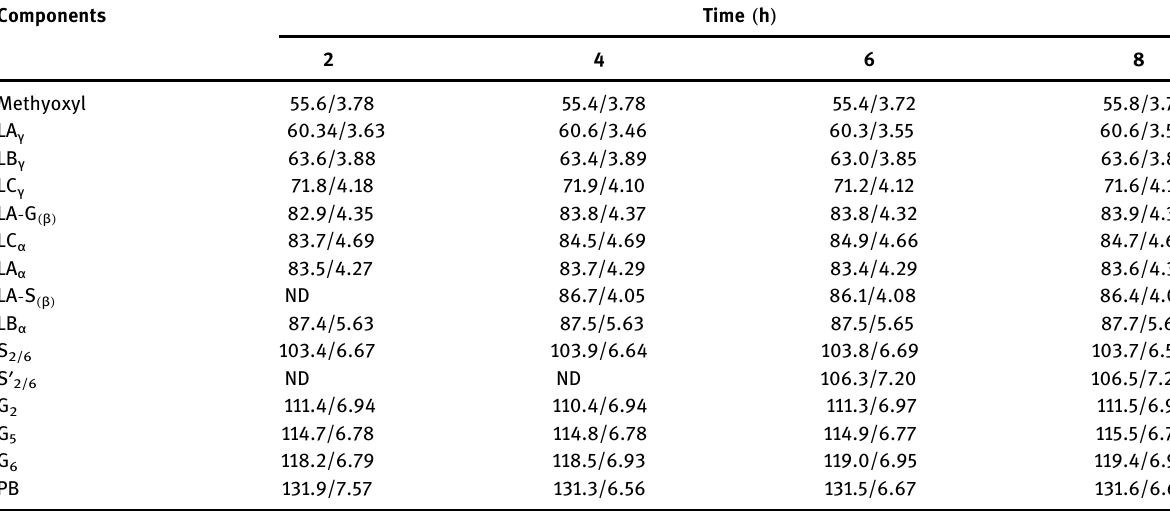
Table 2: Assignments of cross - peaks in the 2D HSQC NMR spectra of tobacco leaf cell walls at di ff erent ball milling times Components